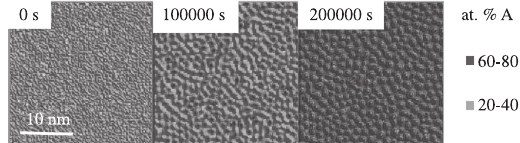
Figure 9. Microstructural evolution for B-50at.%A alloy for = 16628 J/mol at 650 Ω A-B